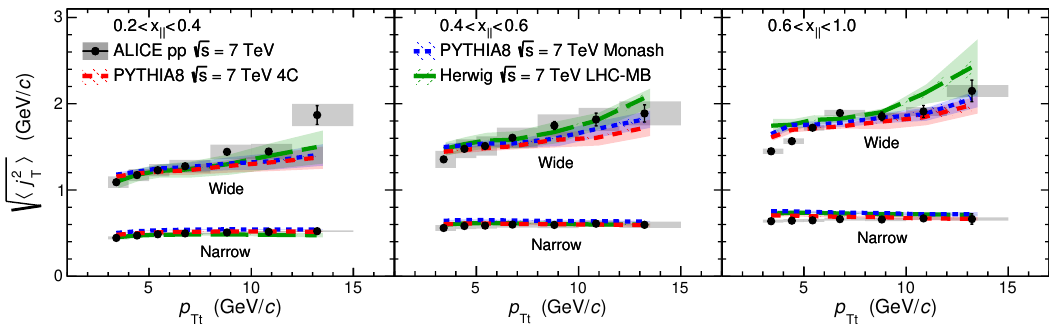
p Figure 6 . RMS values of the narrow and wide j T components for pp collisions at s = 7 TeV (circular symbols) compared to Pythia 8 tunes 4C (dashed line) and Monash (short dashed line), and Herwig 7 LHC-MB tune (long dashed line) at the same energies. Di(cid:11)erent panels correspond to di(cid:11)erent x bins with 0 : 2 < x < 0 : 4 on the left, 0 : 4 < x < 0 : 6 in the middle, and 0 : 6 < x < 1 : 0 k k k k on the right. The statistical errors are represented by bars and the systematic errors by boxes.